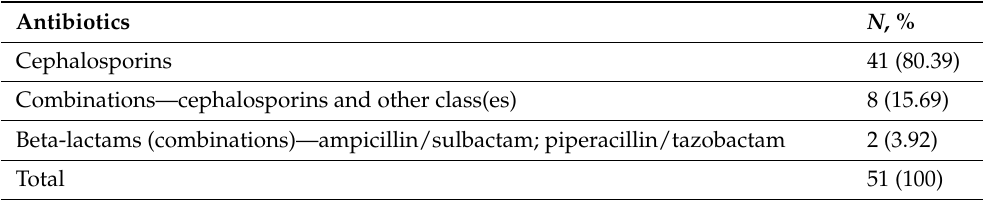
Table 3. Antibiotics used postoperatively—simple